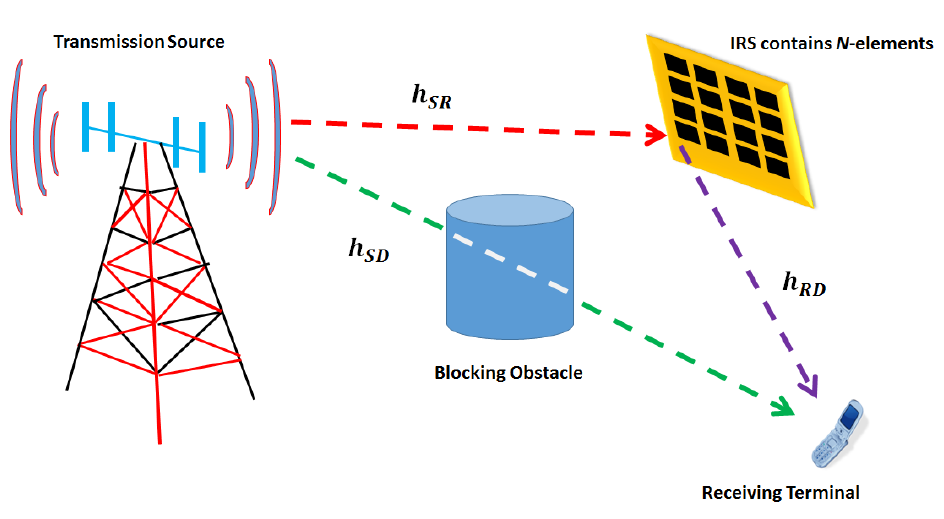
Figure 1. An illustration of the modeled IRS-assisted